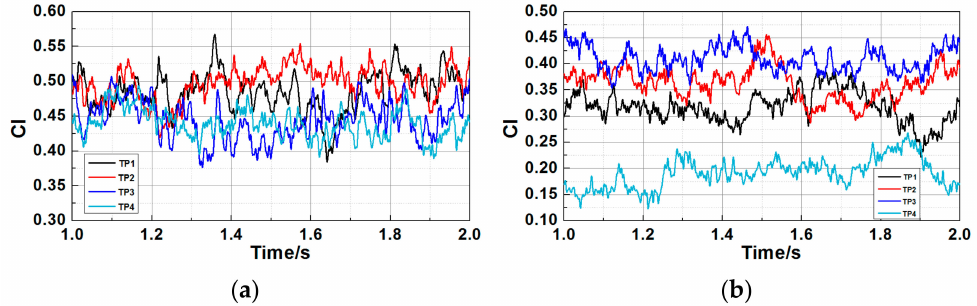
Figure 23. Cl on the head and tail in time domain: ( a ) head; ( b )